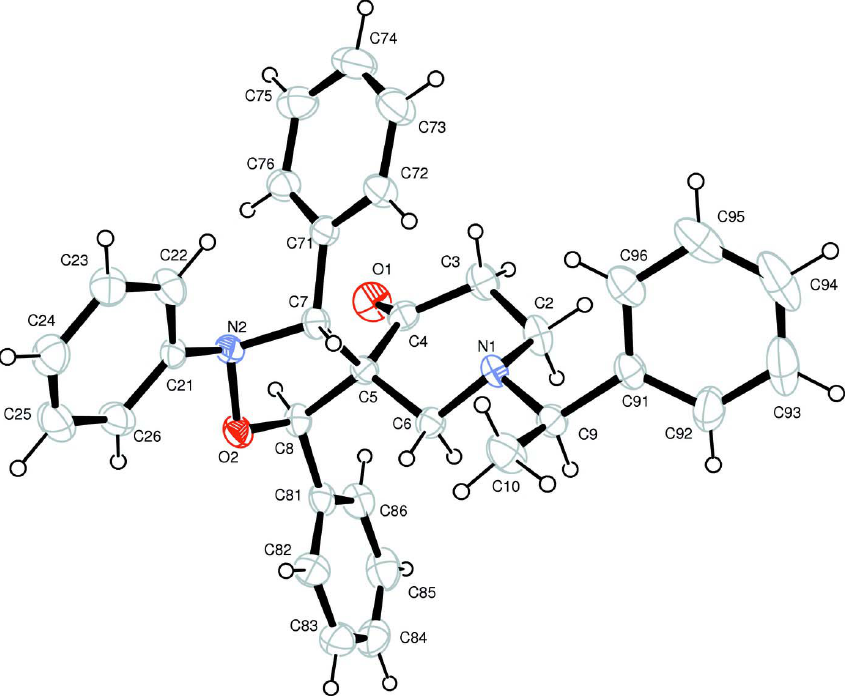
Figure 1 The molecular structure of the title compound, showing 30% probability displacement ellipsoids and the atom-numbering